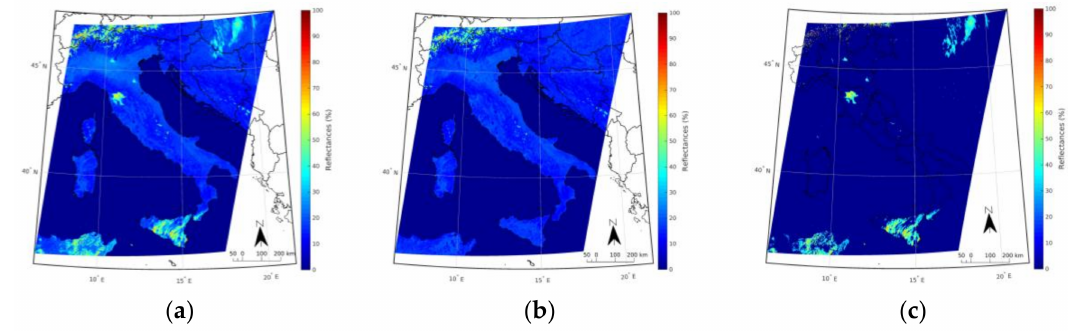
Figure 4. Steps to obtain High Resolution Visible channel (HRV)Long Term Temporal Test (LTTT) product: ( a ) HRV Reflectance over land, 2017-04-10 07:45 UTC; ( b ) Clear sky reference map; ( c ) HRV Reflectance over land, cloudy